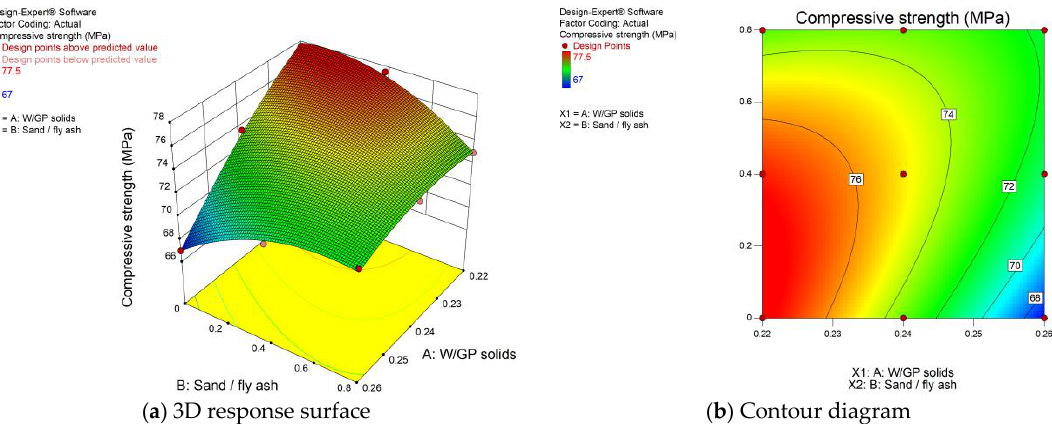
Figure 5. Compressive strength versus W/GP solids and sand/fly ash . ( a ) 3D response surface, ( b ) contour diagram.